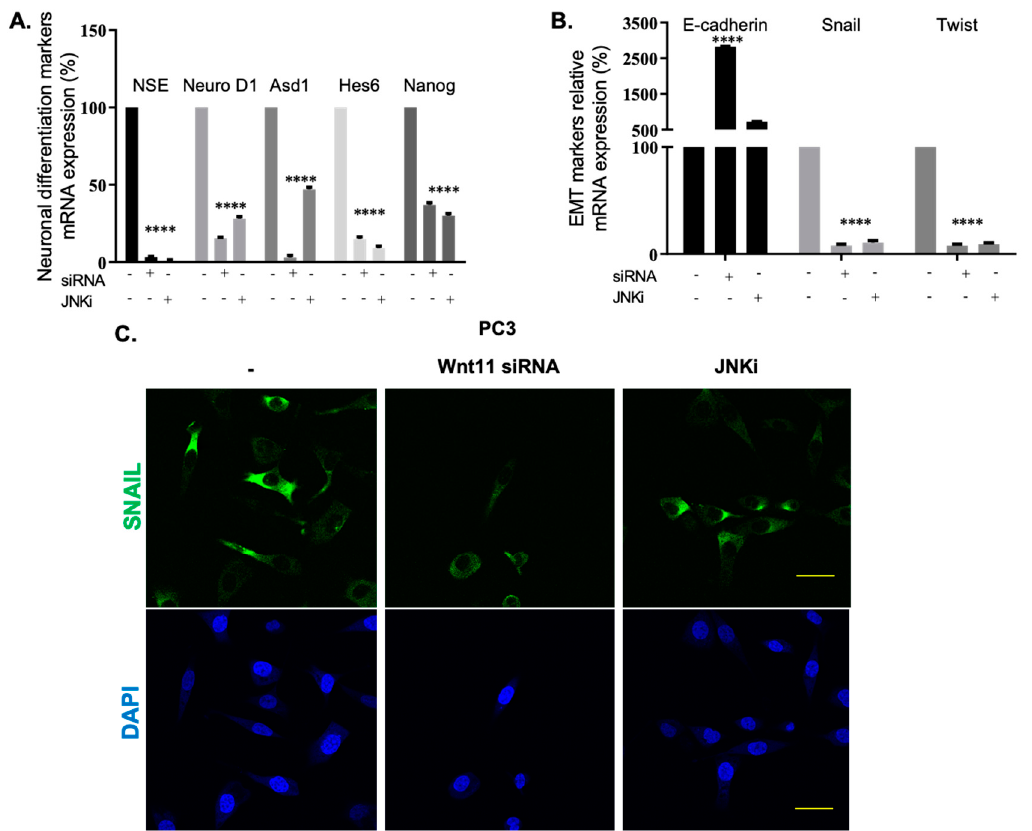
Figure 5. The effects of Wnt-11 on the neuronal differentiation and EMT markers in JNKi-treated PC-3 cells. PC-3 cells were transfected with Wnt-11 siRNA for 48 h. ( A ) The mRNA levels of NSE, Ascl1, Hes6, and Nanog in the control, as well as Wnt-11-silenced and JNKi-treated PC-3 cells were determined by RT-PCR ( p < 0.0001). ( B ) The mRNA levels of E-cadherin, Snail, and Twist in PC-3 cells were determined by RT-PCR. Data from at least three independent experiments with duplicate treatments are shown ( p < 0.0001). ( C ) Immunofluorescence localization of Snail in Wnt-11-silenced PC-3 cells and JNKi-treated-PC-3 cells compared to control cells. DAPI (4’,6-diamidino-2-phenylindole) was used for nuclear staining. Scale bar is 10 µm. Representative images of this experiment were taken from three biological repeats.